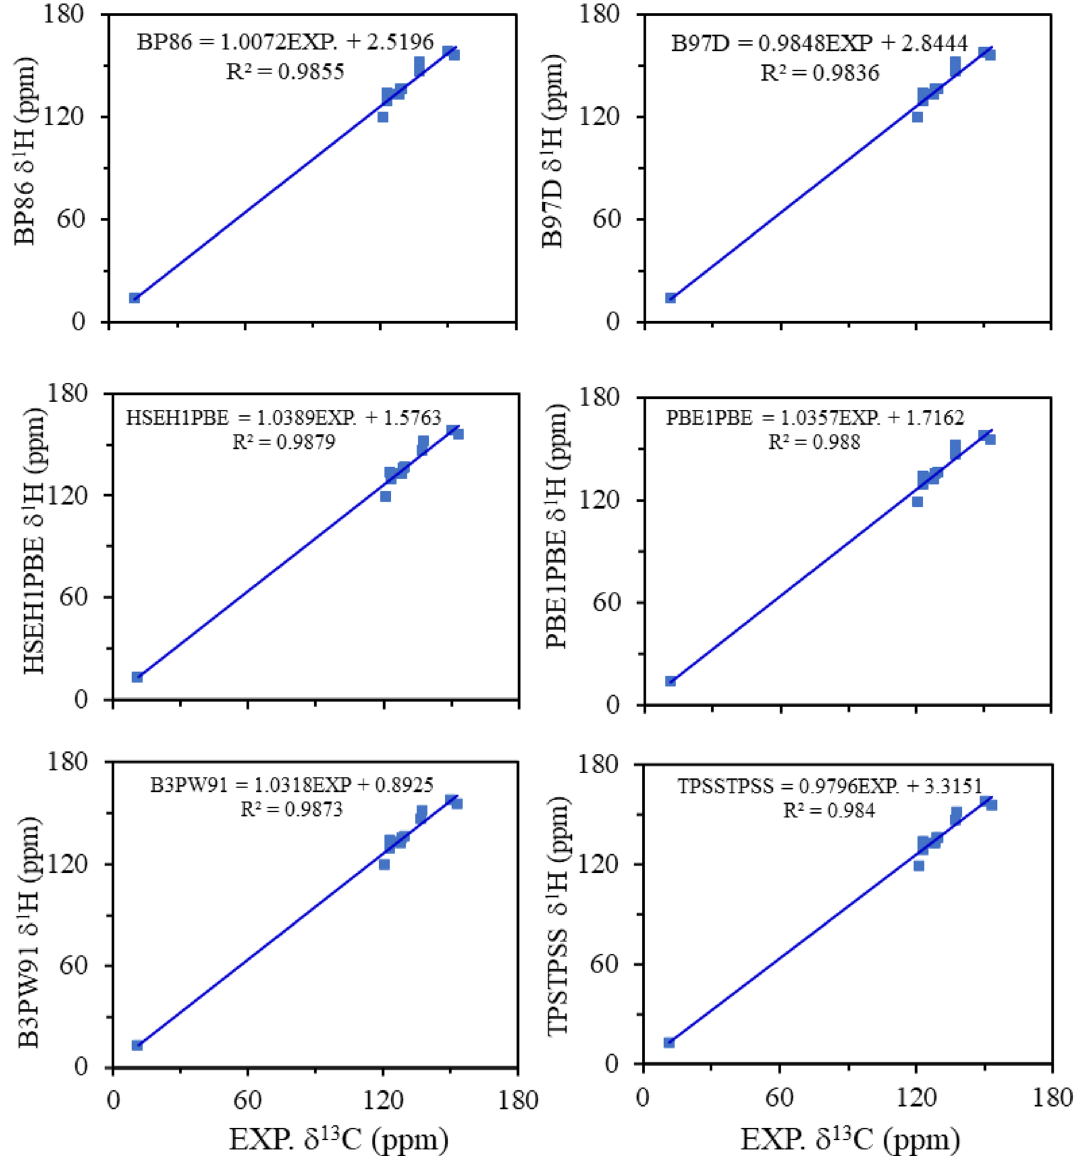
Figure 6. Correlation between the experimental 13 C-NMR chemical shifts and the computed 13 C-NMR chemical shifts as calculated using six different DFT methods (BP86, B97D, HSEH1PBE, PBE1PBE, B3PW91, and TPSSTPSS) with TZVP basis set at the B3LYP/TZVP geometry ( TBT